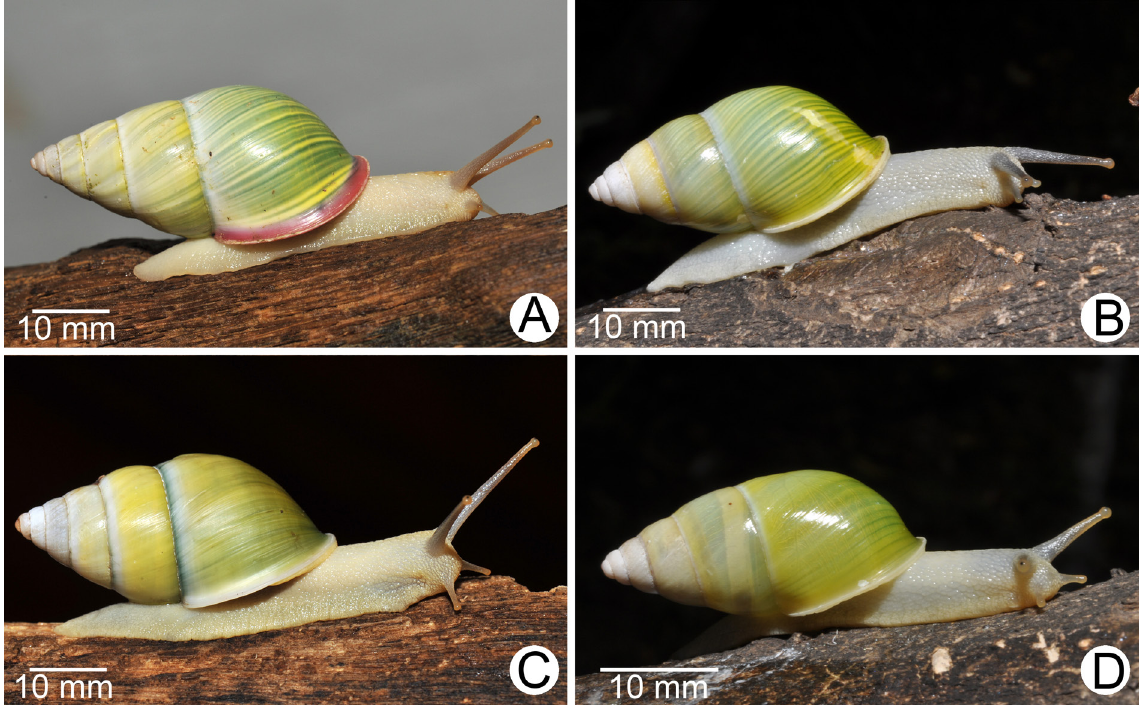
Fig. 2. Living snails. A–B . Amphidromus roseolabiatus Fulton, 1896. A . Typical form from Ban Phavong, Khammouan, Laos (CUMZ 7012). B . Form with white lip from Tam Mung Korn, Bolikhamxay, Laos (CUMZ 7005). C . Amphidromus givenchyi Geret, 1912 from Thad Lor Waterfall, Salavan, Laos (CUMZ 7018). D . Amphidromus syndromoideus sp. nov., holotype from the type locality (CUMZ